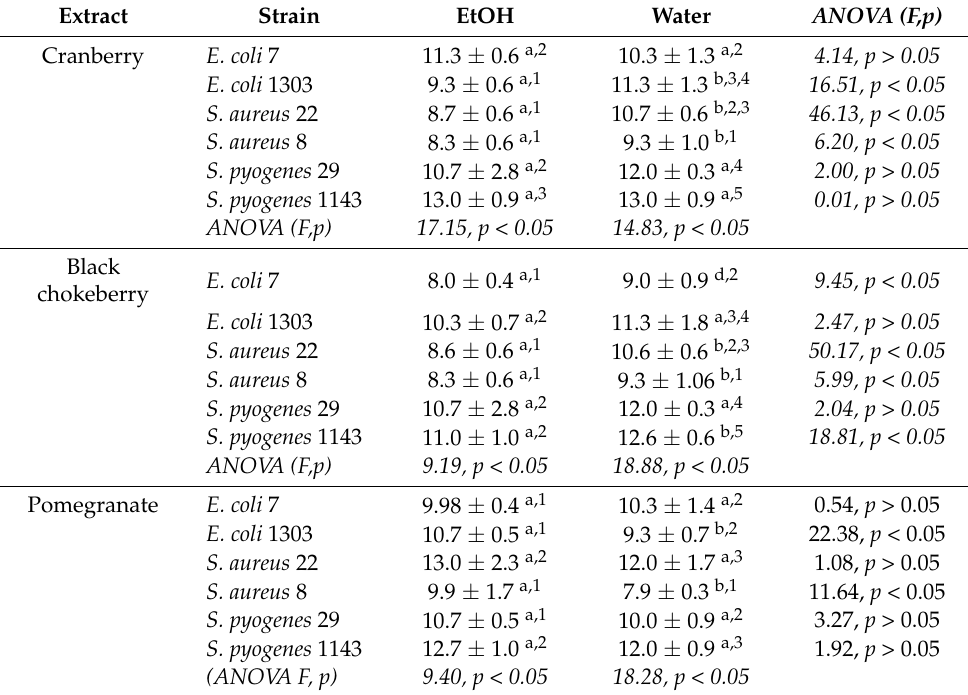
Table 4. Zones of inhibition (ZOIs) of various fruit extracts against pathogens. Extract Strain EtOH